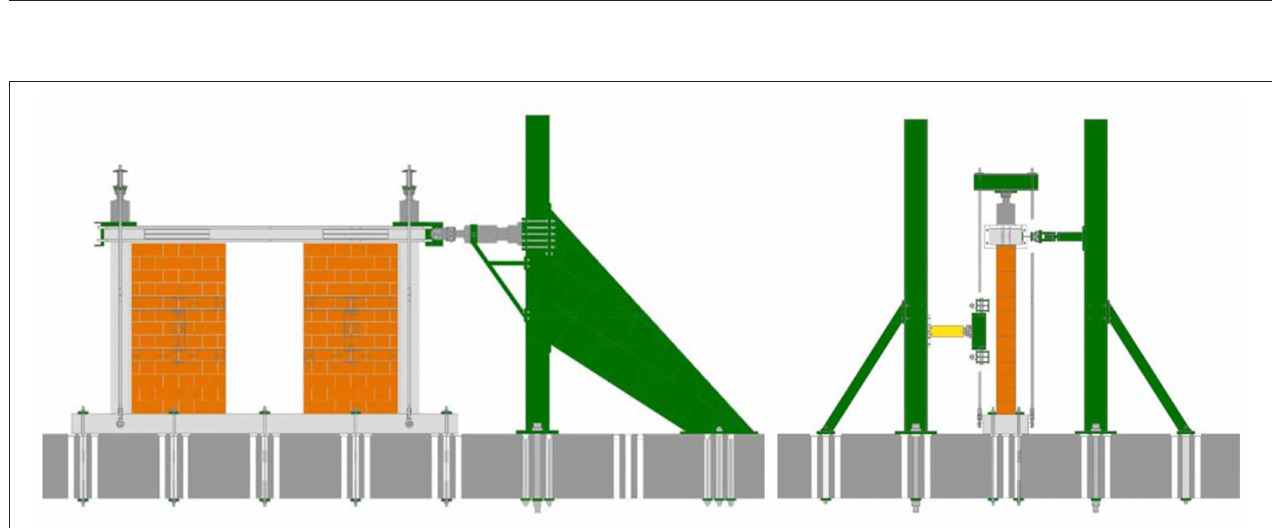
FIGURE 4 | In-plane (left) and out-of-plane (right) test setup.